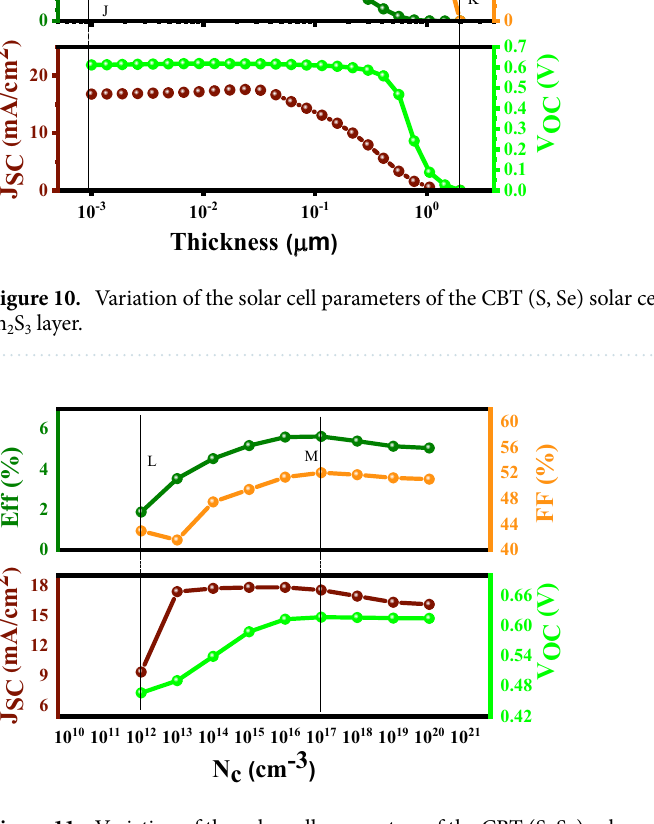
Figure 11. Variation of the solar cell parameters of the CBT (S, Se) solar cells with different N C (cm −3 ) of the In 2 S 3 layer.